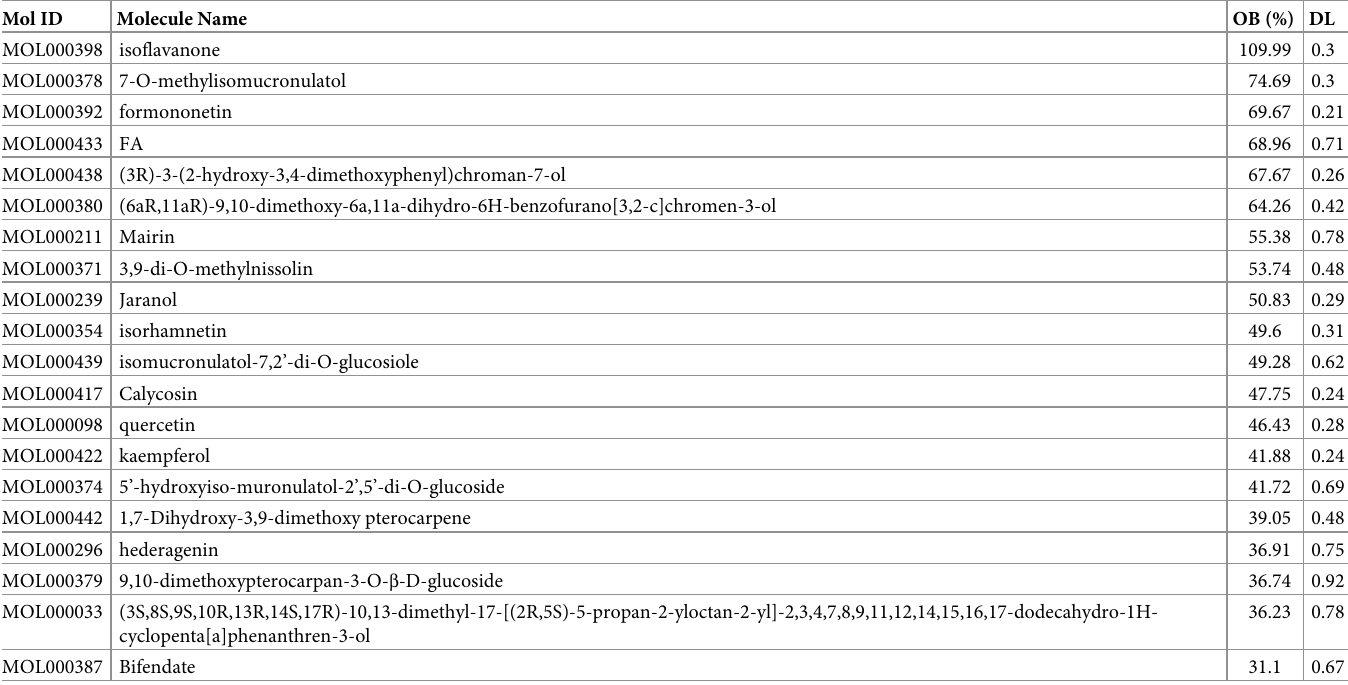
Table 1. Active compounds in